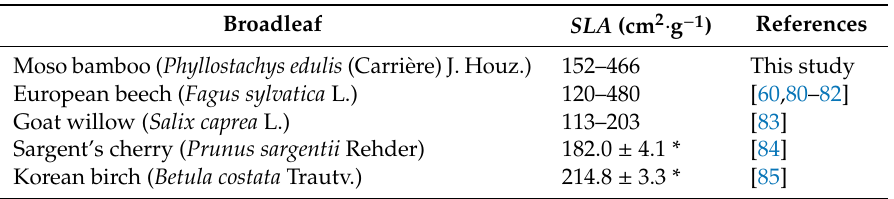
Table 3. Specific leaf areas ( SLA s) of several broadleaf tree species.